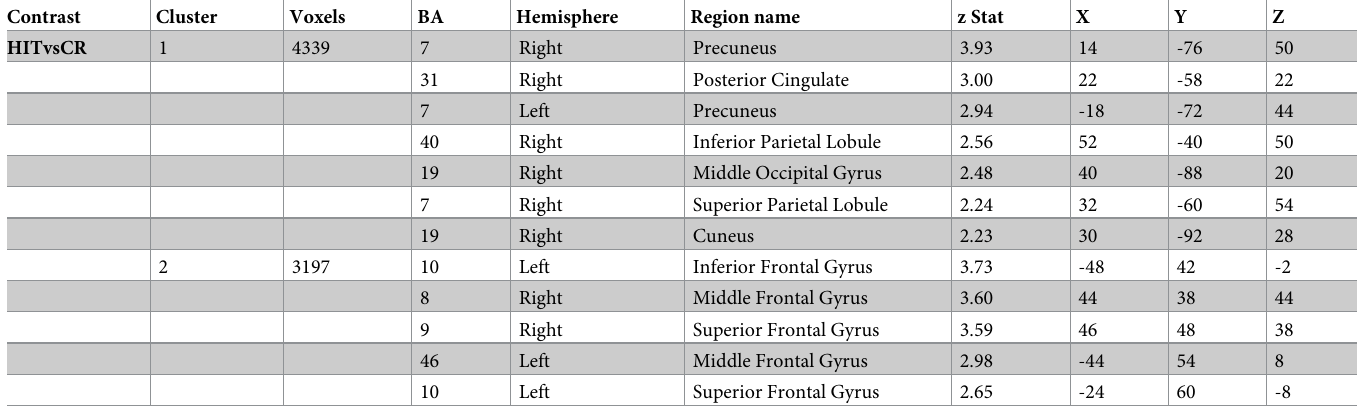
Table 2. Replication: Activation peaks for HIT vs. correct rejection within remote retrieval runs.